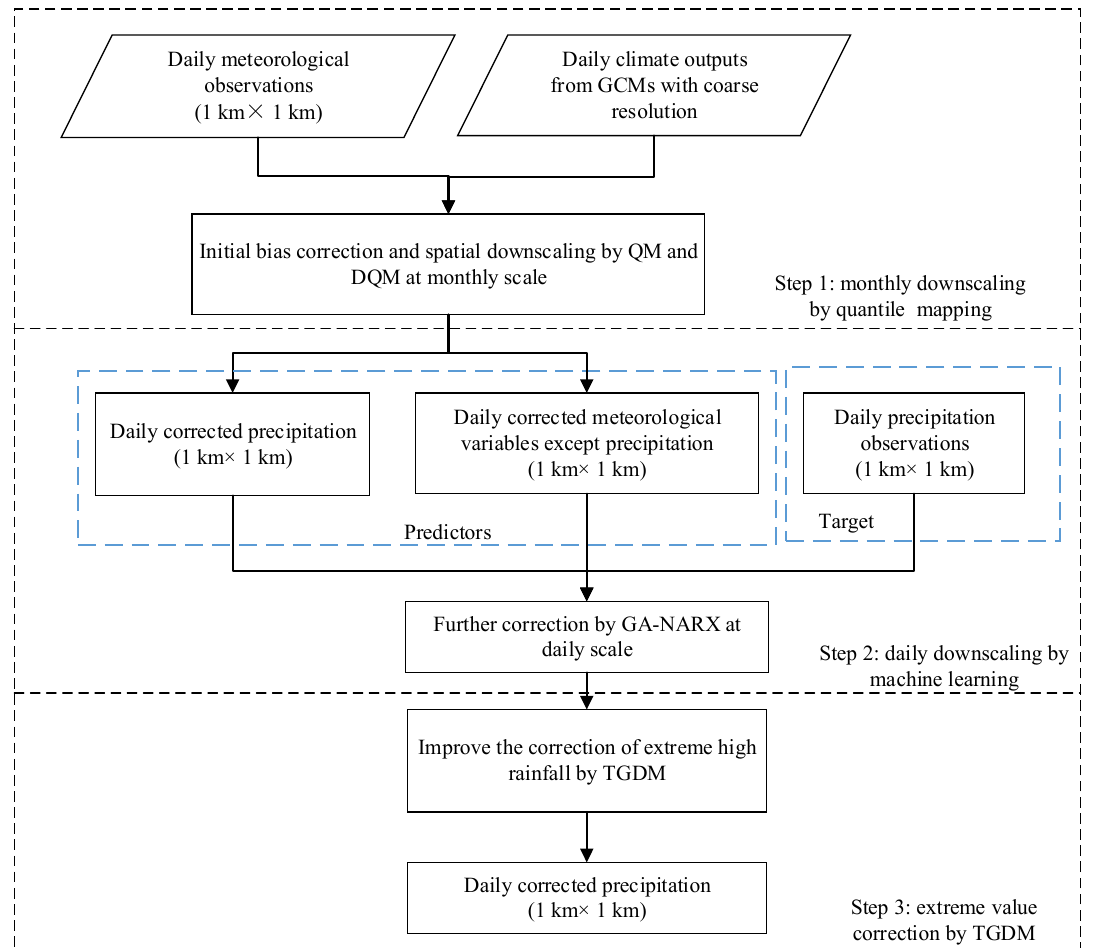
Figure 2. Flowchart of the quantile mapping-machine learning combined method.